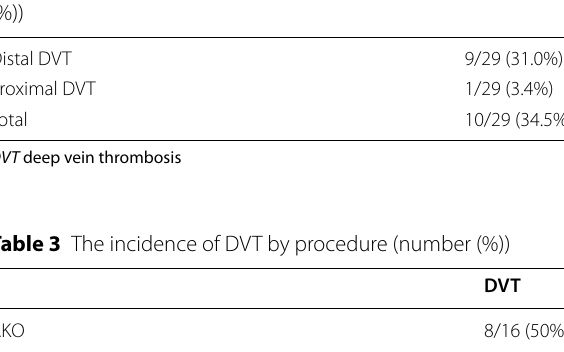
Table 2 Location of DVT in the study population (number and